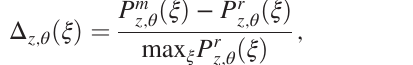
FIG. 4. Reconstruction from simulated measurement. The original distribution in the transverse phase space is shown in the upper row. An astigmatism of − 1 cm is added to the horizontal plane (tilt in x − x 0 ). The algorithm reconstructs the transverse phase space based on a set of simulated wire scan projections. The result of the reconstruction is shown in the lower row. The 1 σ -ellipse of a 2D Gaussian fit is drawn in blue for each